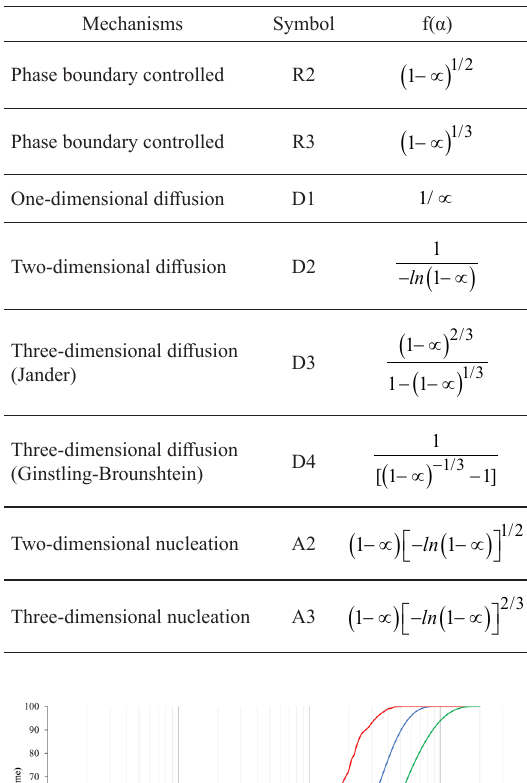
Table 3. Kinetic models for the gas–solid reaction.